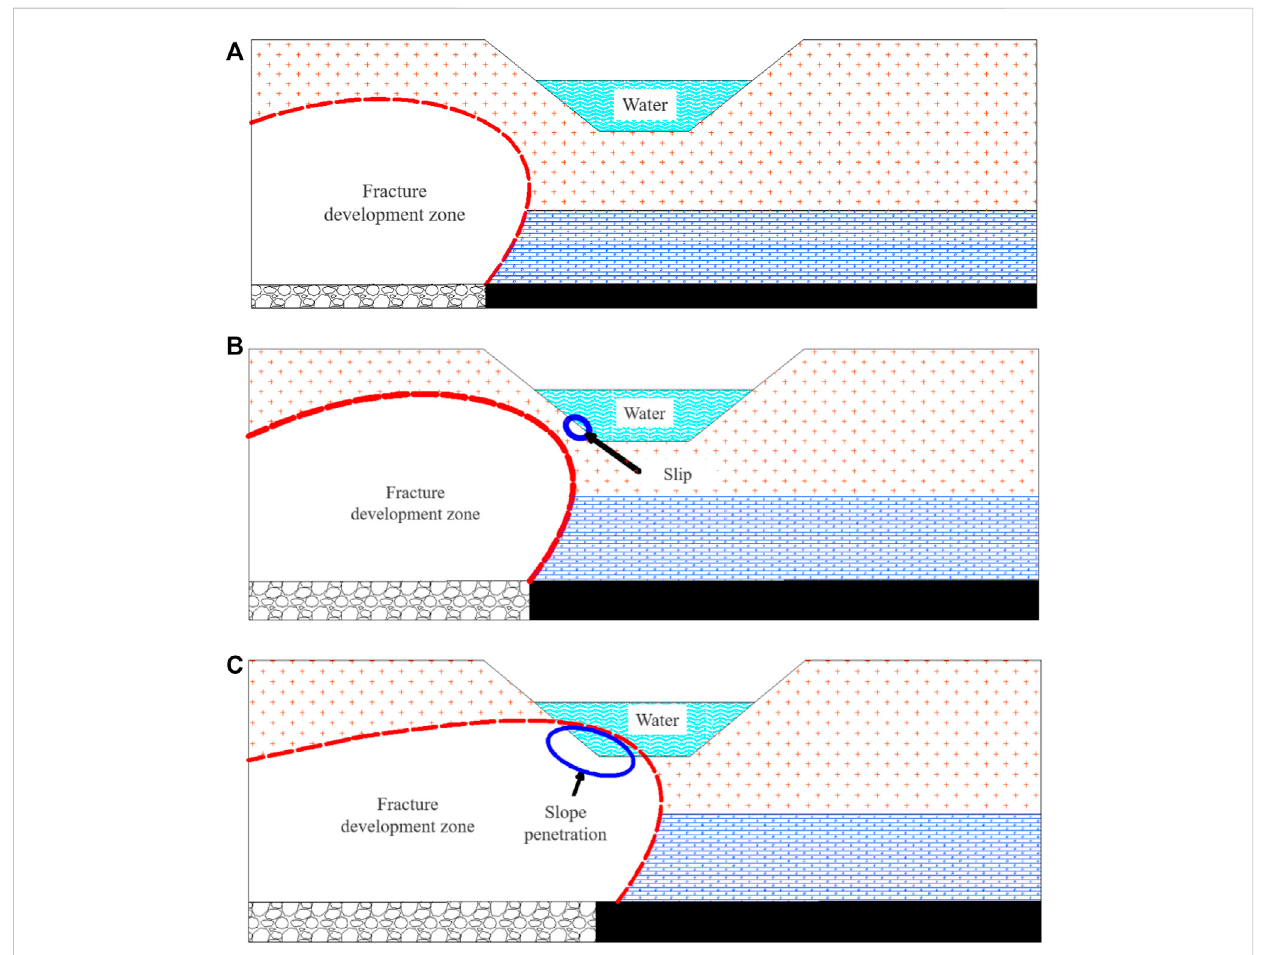
FIGURE 12 Development process of mining-induced fractures. (A) Early stage of cross-gully mining (B) Interim stage of cross-gully mining (C) Late stage of cross-gully